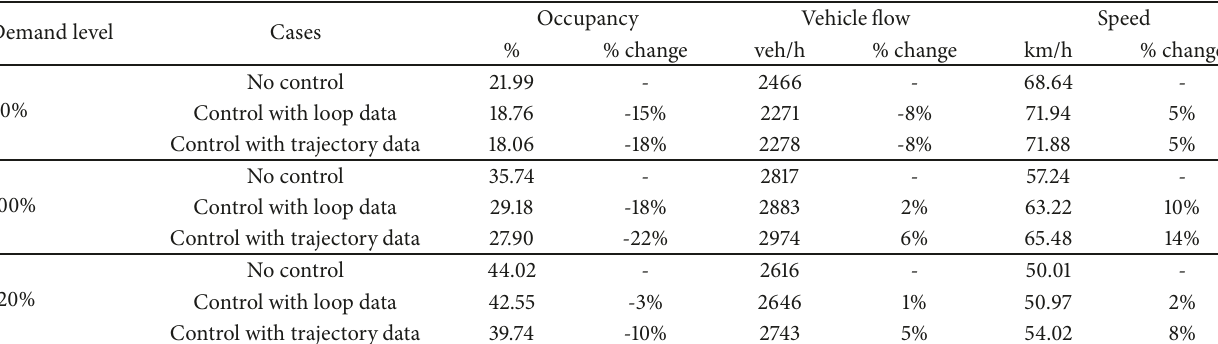
Table 2: Mainline performance